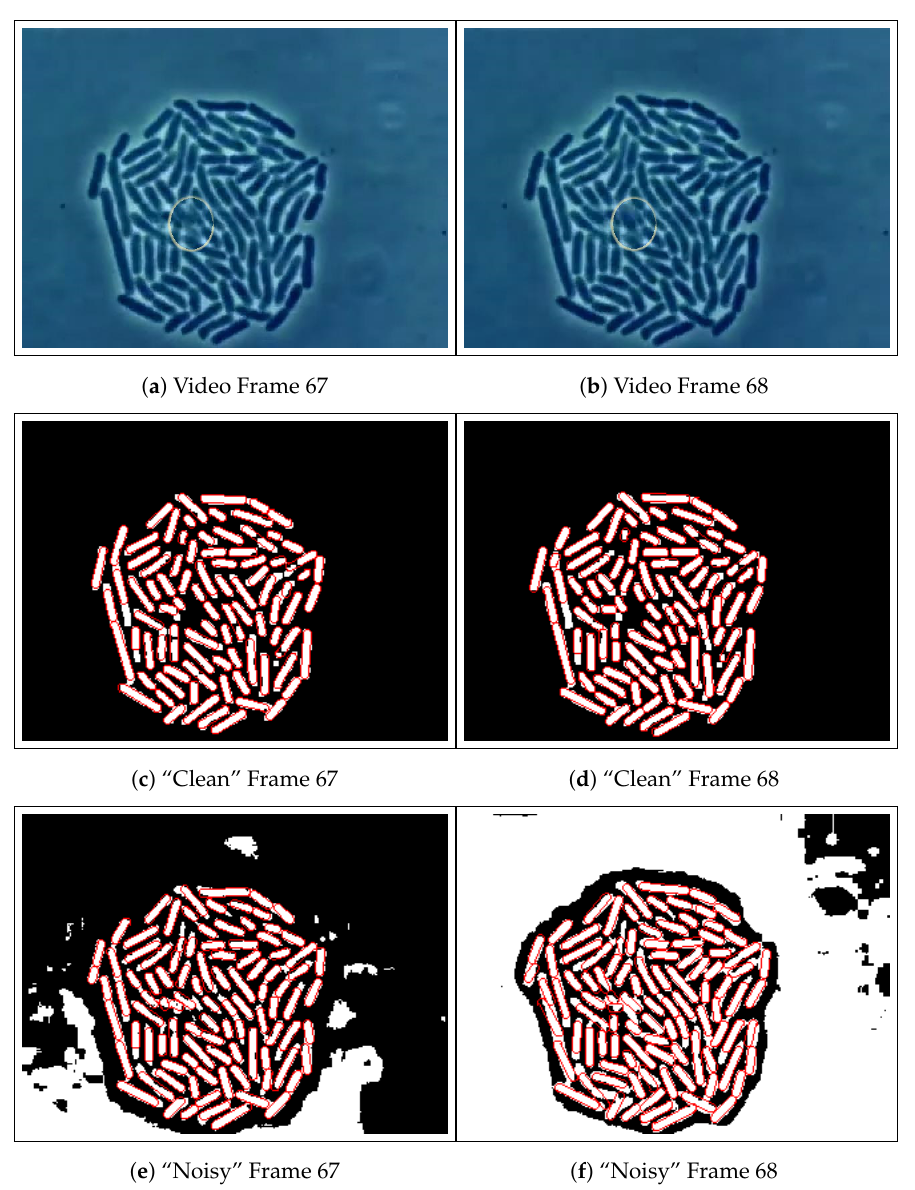
Figure 5. Between Frames 67 and 68, our algorithm (as well as all of the other techniques) begins to encounter difficulty tracking cell movements in the center of the colony as cells move off of the focal plane ( a , b ). Some cells removed by our more aggressive “clean” thresholding ( c , d ) are visible in our lenient, “noisy” thresholding ( e , f